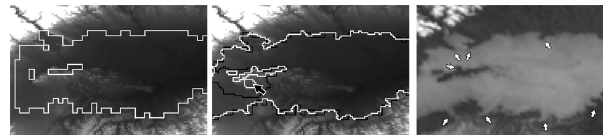
Fig. 10. FLS masks (indicated by the white outline) in 3km (left) and 1km (center) resolution for fog in the Po Valley on 22 De- cember 2008. The masks’ outlines are underlaid by a DEM. White line = boundary of the 3km and 1km masks. Black line = boundary of an additional FLS mask based on channels interpolated to 1km resolution. White arrows = details that strongly benefit from the res- olution enhancement. Black Arrow = area where FLS was not de-